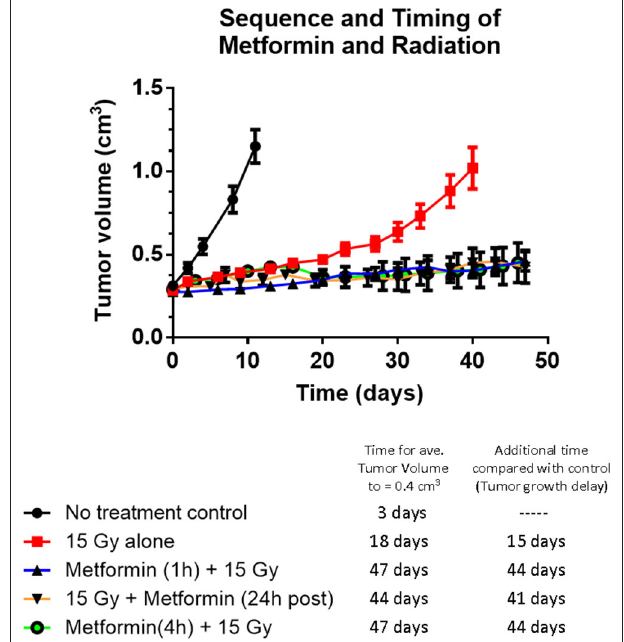
FIGURE 1 | The effect of sequence and timing of metformin and radiation on tumor growth. Tumor growth of A549 human lung carcinoma and tumor growth delay following radiation alone or various timing and sequences of combined administration of metformin (200 mg/kg) and radiation (15Gy). No difference in tumor growth delay was evident whether metformin was administered 1 or 4h before radiation or metformin was given 24h after radiation (all gave growth delays of 43 ± 2 days) indicating the mechanism of radiosensitization cannot be completely explained by metformin’s effect on tumor oxygen availability. Symbols represent: Black solid circles are no treatment control tumors ( n = 14), red squares are 15Gy alone (n-14), black triangles with blue line are metformin given 1h before 15Gy ( n = 19), open black circles with purple line are metformin given 4h before 15Gy ( n = 4) and upsidedown triangles with orange line are metformin given 24h after 15Gy ( n = 4). The growth of tumors receiving metformin alone was not significantly different to that of no treatment control tumors (data not shown). Error bars represent